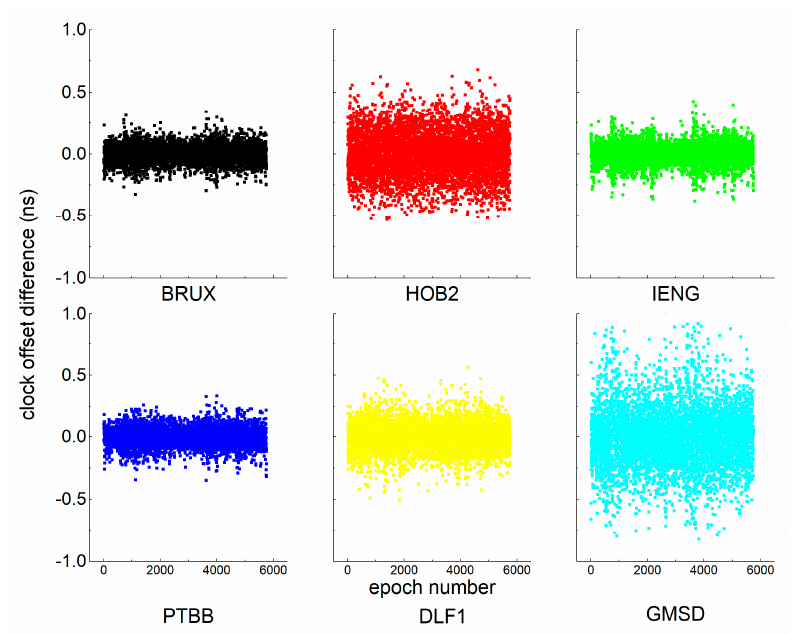
Figure 2. Between-epoch clock offset differences at four stations compared to the IGS final prod- ucts. Table 3. The noise coefficients of the external clock connected with IGS stations.